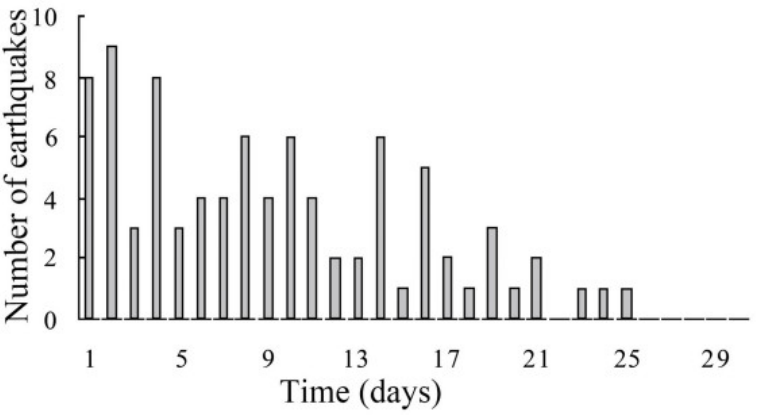
Figure 11. Time distribution of the anomalous infrasound signals before the earthquakes during 2002–2009 [185].